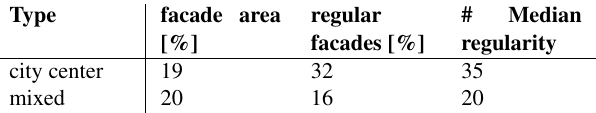
Figure 1. Examples of the two characteristic building area